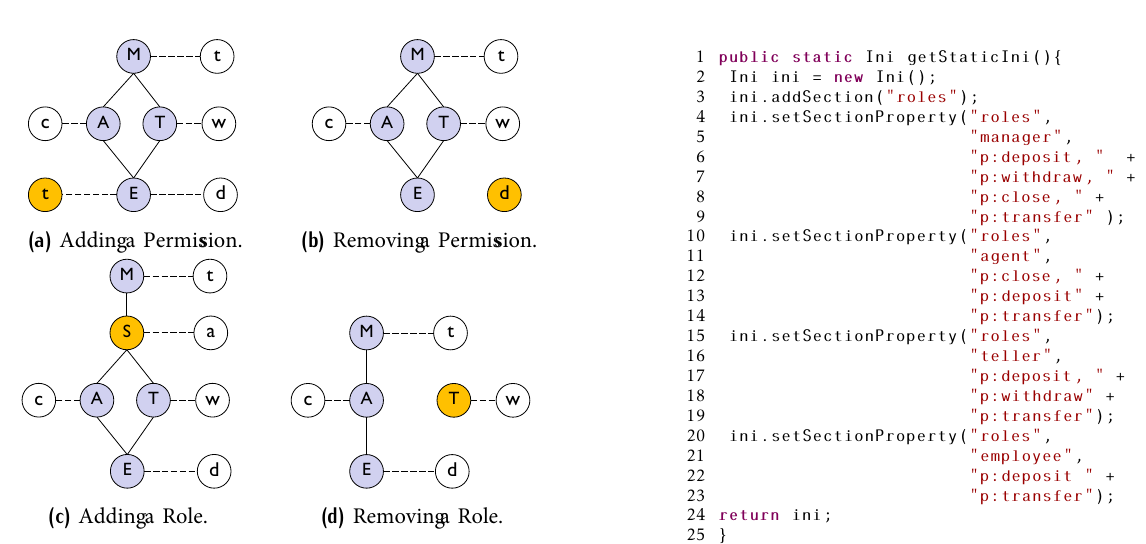
Figure 11. Introducing Mutants in the RBAC Policy shown in Table 2: roles are labeled using their uppercase initial. Permissions are shownusinglowercaseinitials and dottedlines.